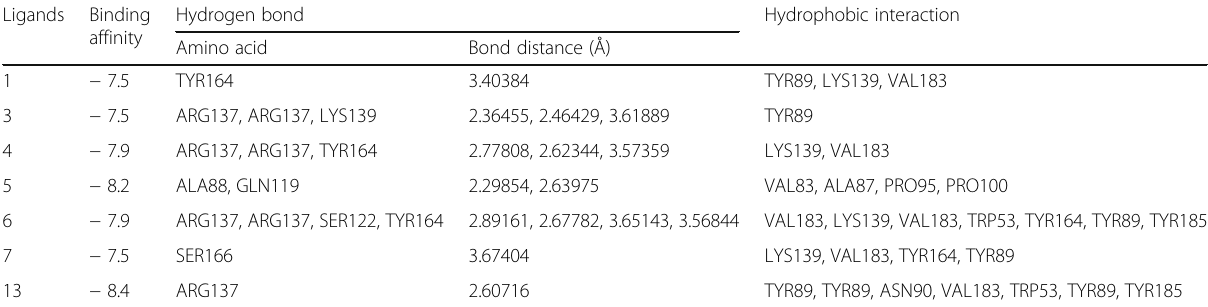
Table 9 Ligands, binding affinity, H-bond, and hydrophobic interaction between high binding score compounds and receptor Ligands Binding affinity